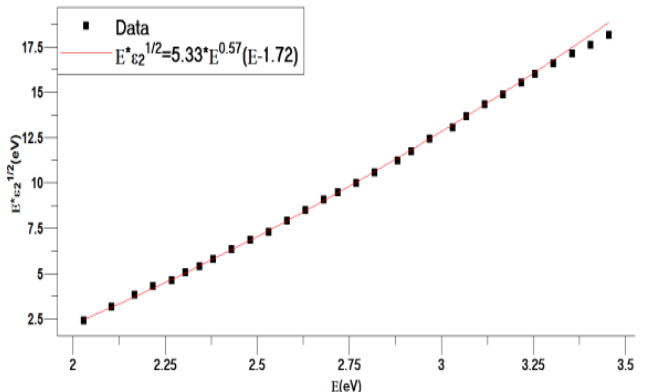
Fig. 5: Data ⁄ for a-Si:H films, where p is